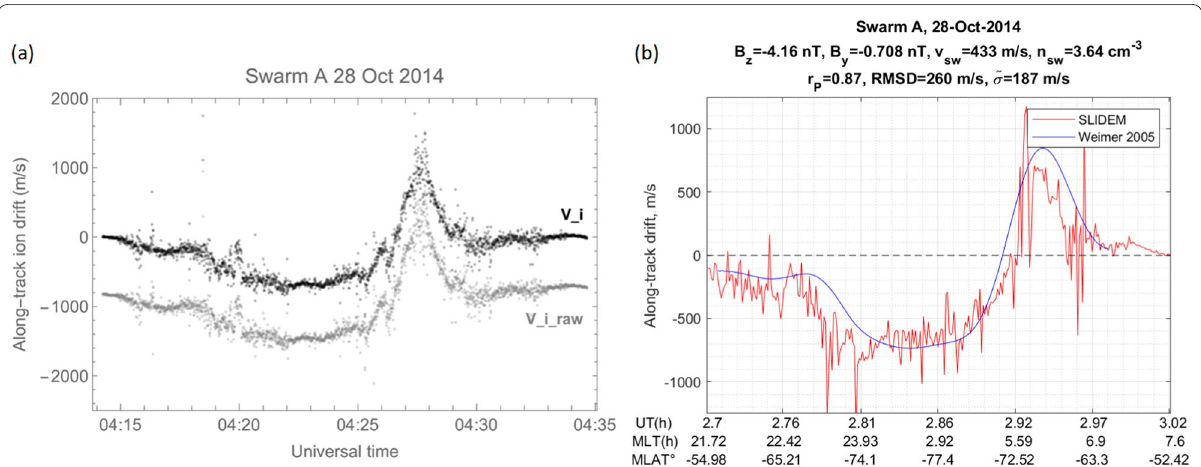
Fig. 7 for a representative auroral zone crossing, a shows along-track drift estimation using the SLIDEM methodology using various methods. The gray plot in a shows the along-track ion velocity estimate derived using Eq. (10), where effective ion mass has been estimated using IRI-2016. Meanwhile, the black plot shows the detrended version of the gray plot, to normalize it such that ion drift at low latitudes is around zero. b Shows a different auroral zone crossing on the same day, with the SLIDEM ion velocity output (red) alongside Weimer 2005 ion drift estimations